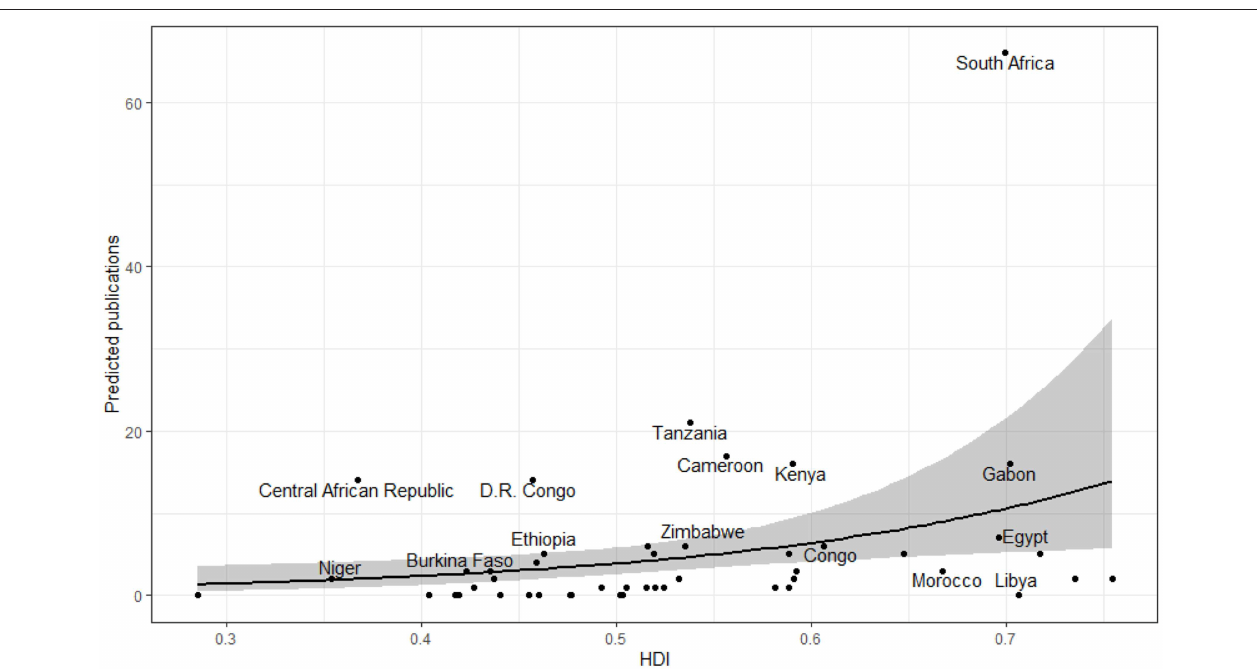
FIGURE 4 | Predicted number of publications per country plotted against the Human Development Index of that country. The grey shading represents the 95% CI.